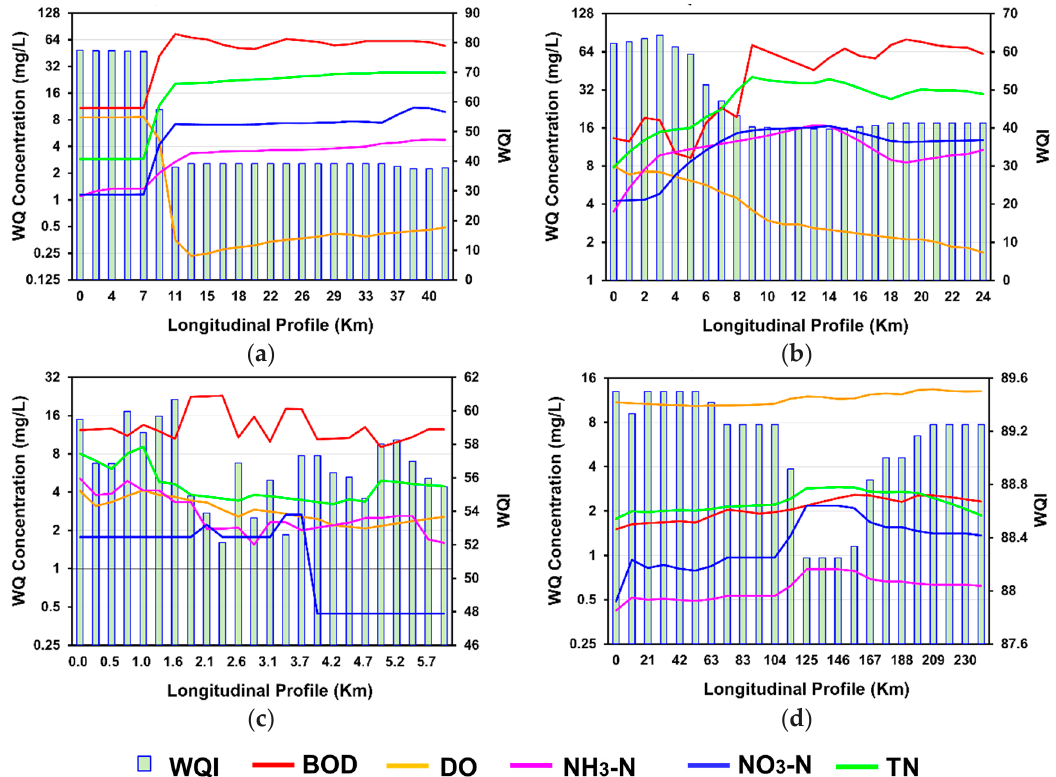
Figure 8. Spatial effect of water quality concentration on the overall water quality index ( a ) Yamuna River, ( b ) Baghmati River, ( c ) Galing River, and ( d ) Nakdong River.